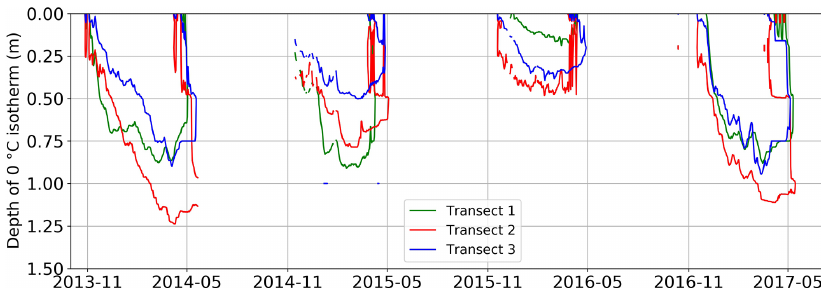
Figure 6. Soil freezing depths in three soil profiles near Wetland 109.